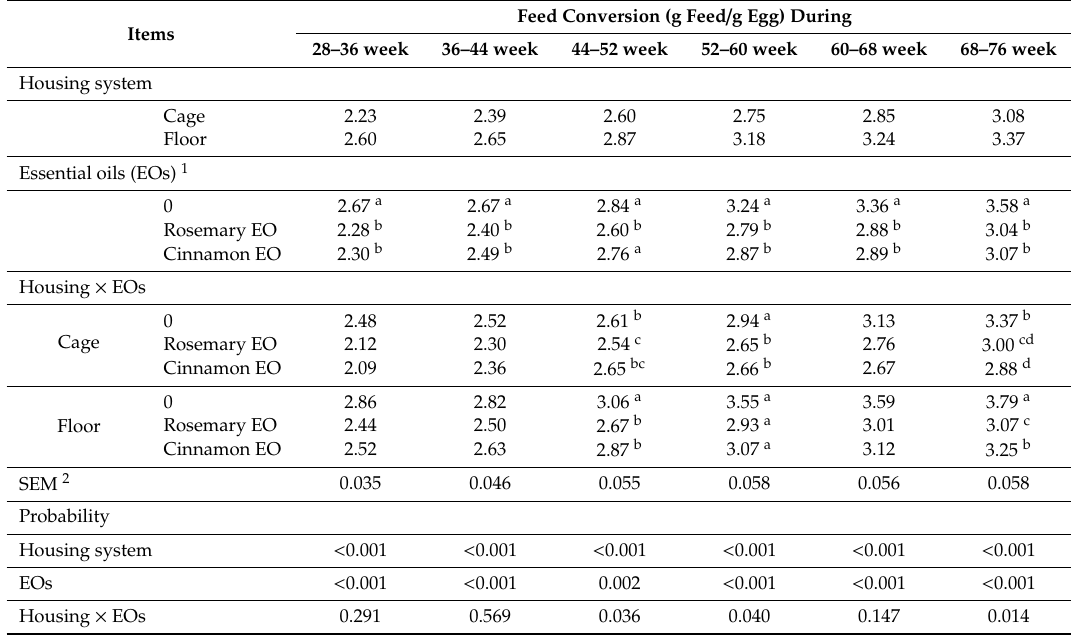
Table 6. Feed conversion of laying hens as a ff ected by di ff erent housing systems, essential oils and their interaction during the